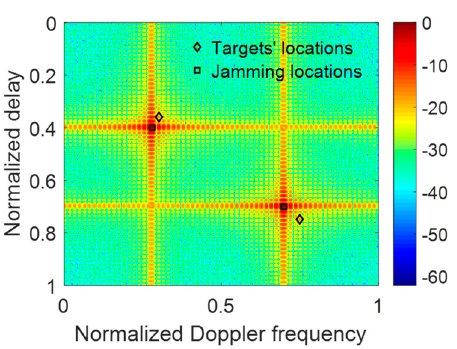
Figure 10. The countermeasure effect in the presence of the JRVDJ.